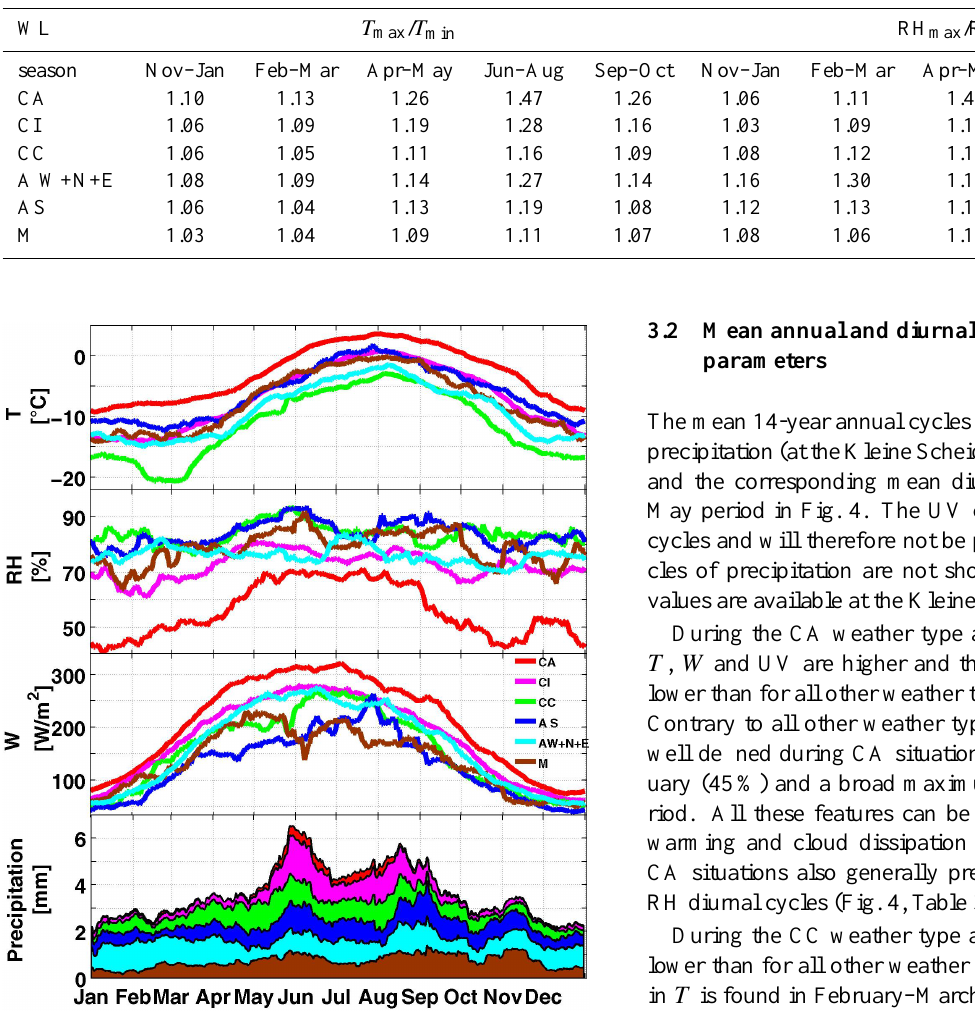
Table 3. Diurnal cycle amplitude (maximum/minimum) for the temperature and the relative humidity as a function of the season and the synoptic weather type.